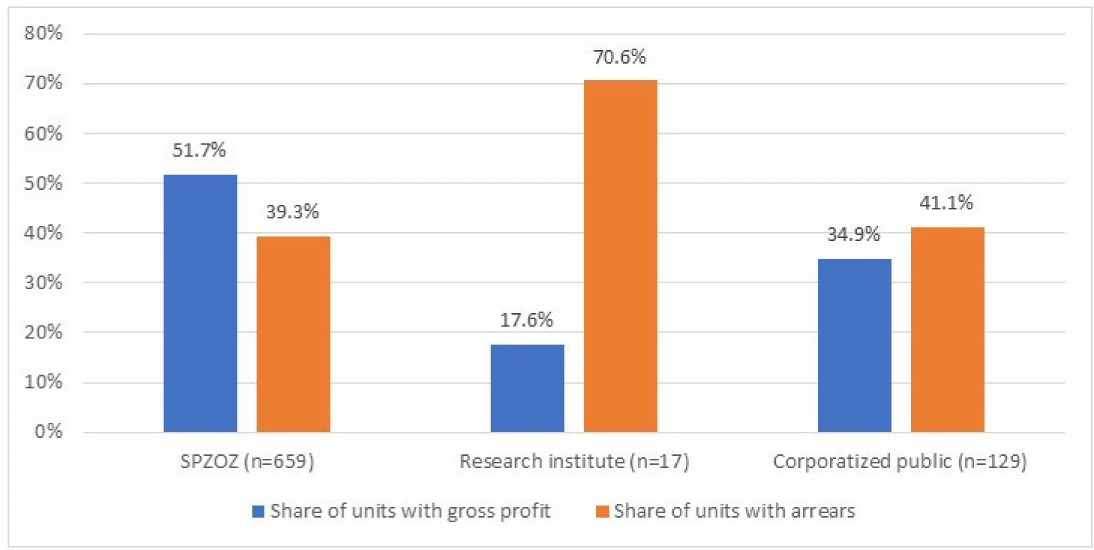
Figure 2. Share of hospitals with gross profit and arrears (%) per organizational form, in 2018. ( p -values from χ 2 test; p -value < 0.001 for both categorical variables.)